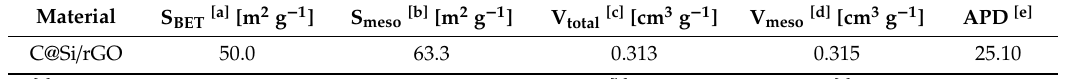
Figure 3. ( a ) N 2 isotherm absorption-desorption curves of C@Si/rGO film; ( b ) Pore-size distribution of C@Si/rGO film. / Table 1. BET and pore data for C@Si/rGO.